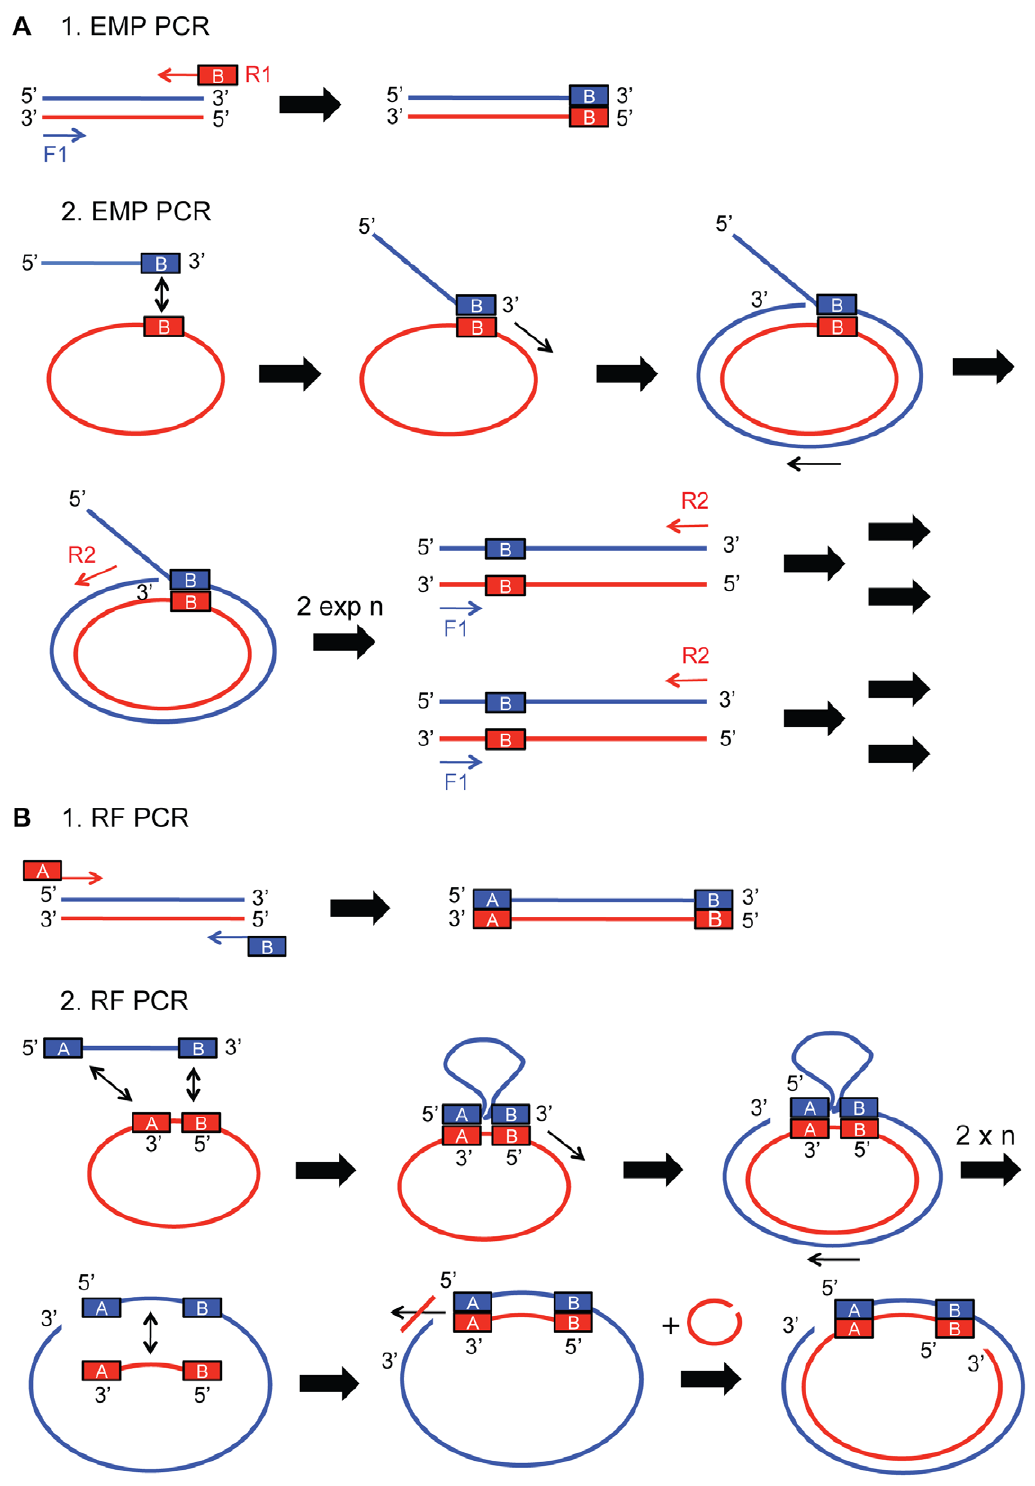
Figure 1. Mechanisms of EMP and RF cloning. Mechanistic details of EMP and RF cloning are compared. (A) EMP cloning involves two PCR reactions. In the 1 st EMP PCR a forward primer F1 and a reverse primer R1 with overhang exponentially amplify the insert of interest. In the 2 nd EMP PCR reaction the purified product is used as a megaprimer to exponentially amplify the target plasmid together with a forward primer F1 and reverse primer R2. (B) RF cloning also includes two PCR reactions. In the 1 st RF PCR two overhang containing primers F1 and R1 exponentially amplify the insert of interest. In the 2 nd RF PCR the purified product is used as a megaprimer to linearly amplify the target plasmid. Experimental procedures are described in detail in Materials and Methods and Tables S1 and S2 .